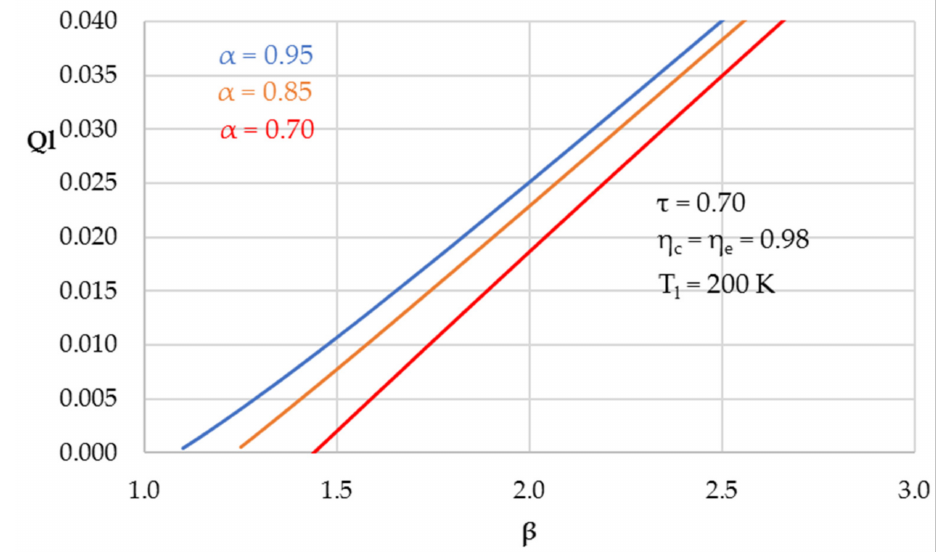
Figure 7. Correlation of the dimensionless refrigeration load Q l with the ratio between the magnetic fields β for various values of α , by fixing τ = 0.7, η e = η c = 0.98 and T l = 200 K.